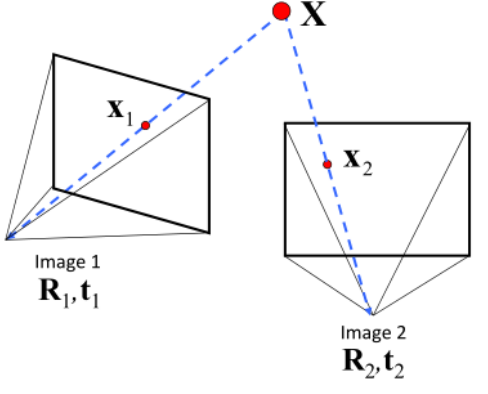
Figure 3. Two view